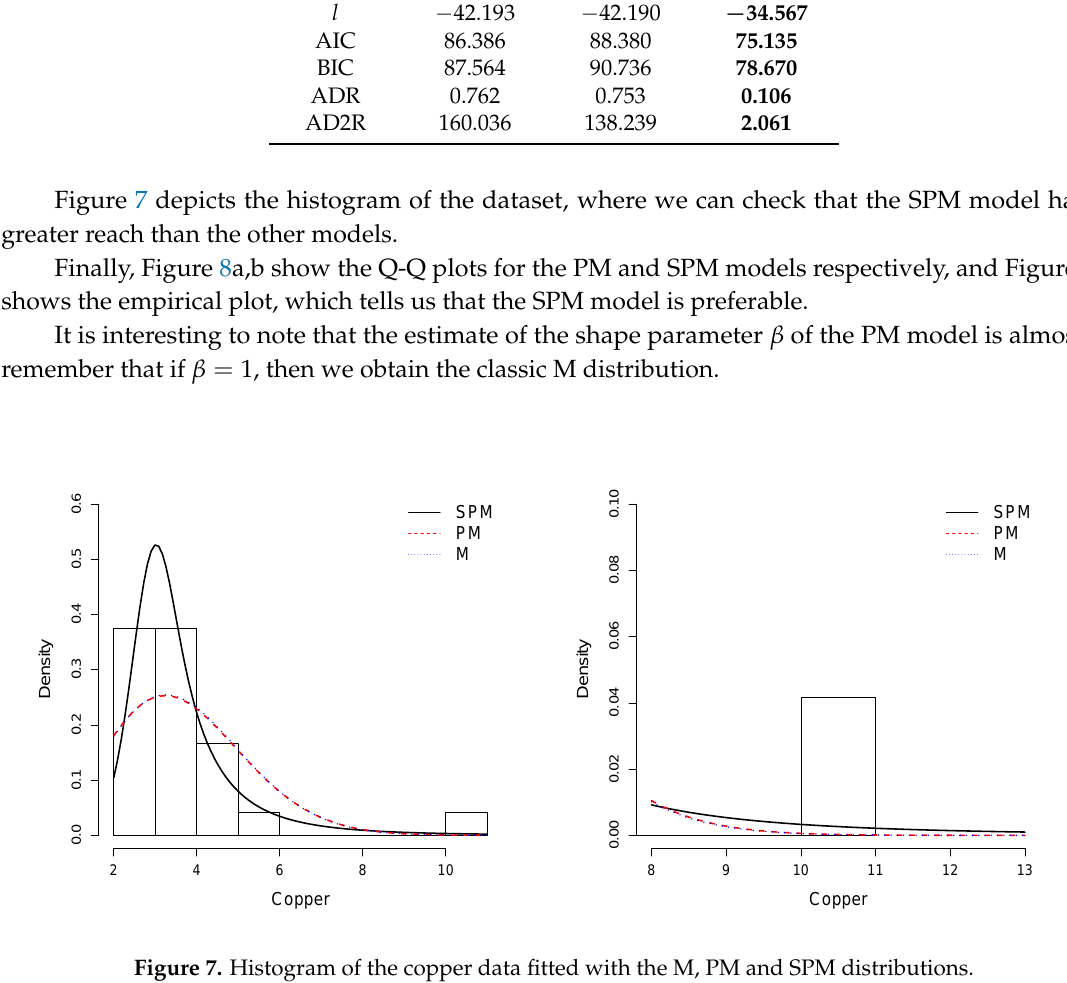
Figure 7. Histogram of the copper data fitted with the M, PM and SPM